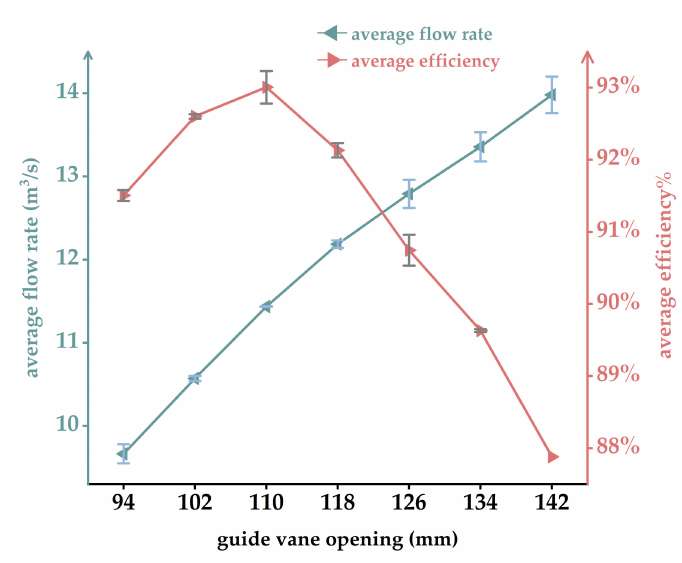
Figure 7. Average efficiency and average flow